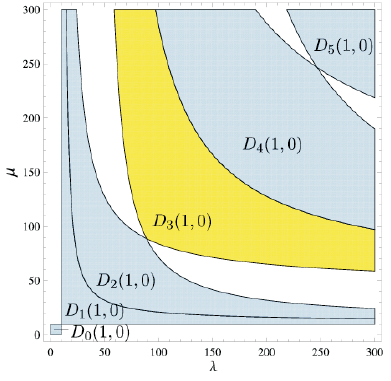
Figure 4. “Good” regions D j (1 , 0) ( j = 0 , 1 ,..., 5) shaded.